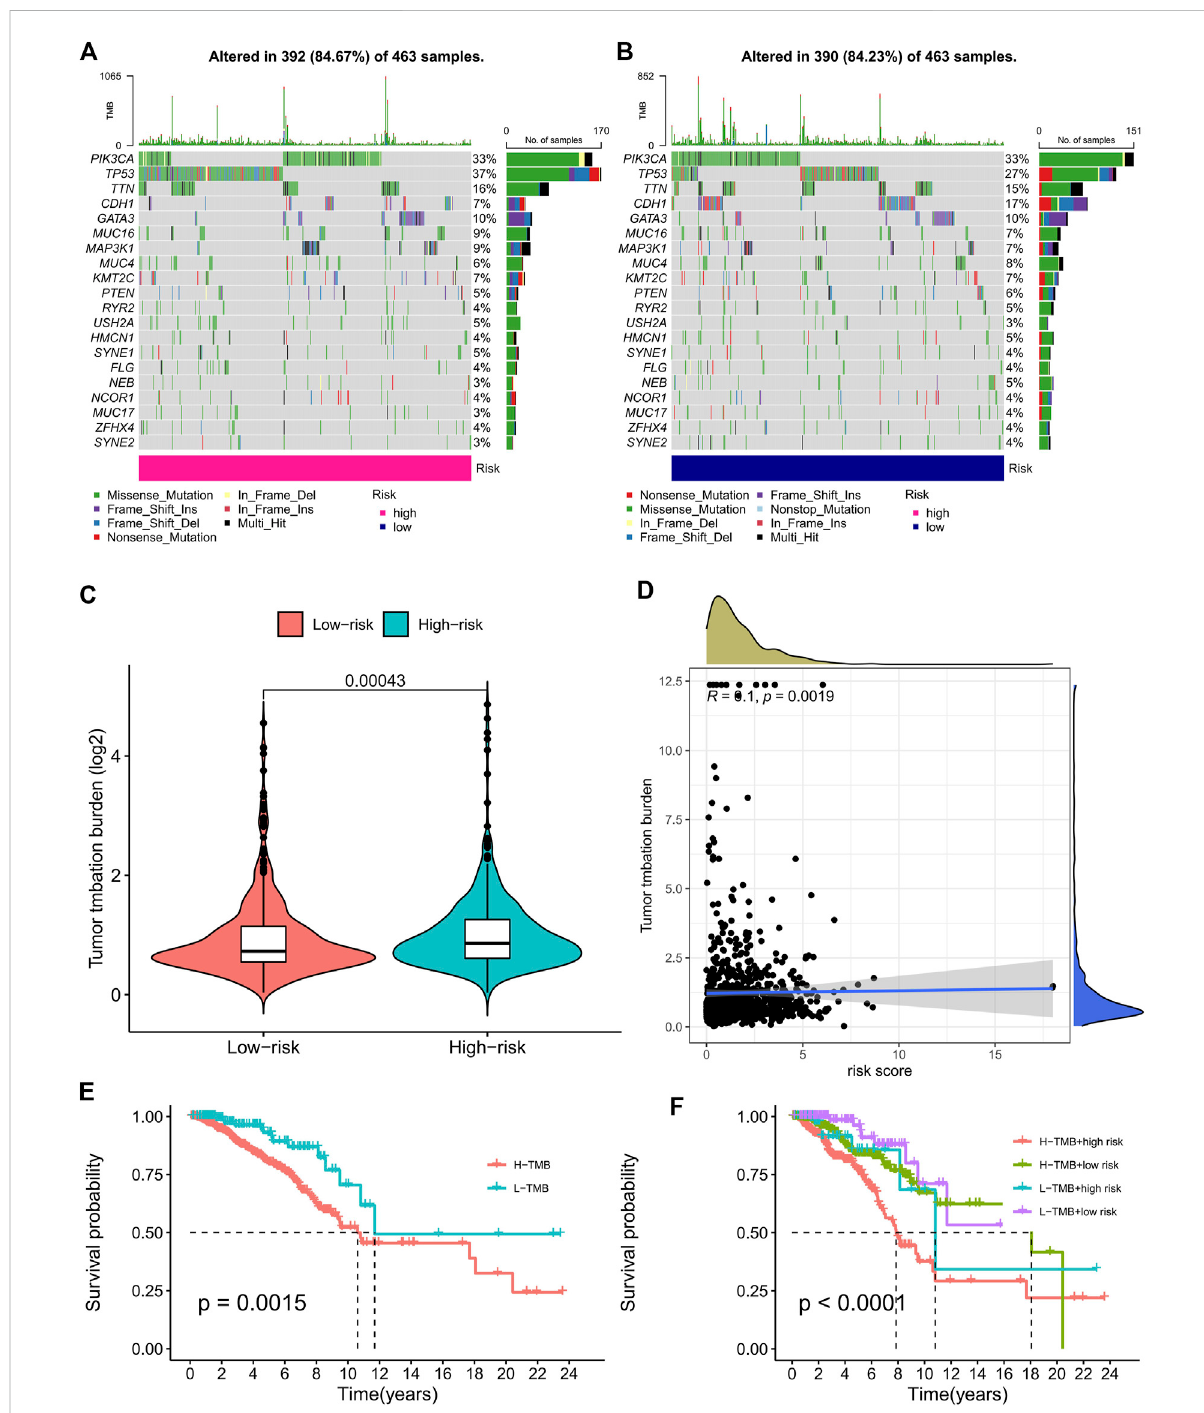
FIGURE 5 TMB analysis of the prognostic signature. (A,B) The waterfall plots of the tumor mutation rate in the high-risk group (A) and low-risk group (B) based on the prognostic signature. (C) The bean plot for the differences in TMB between high- and low-risk groups. (D) The correlation curve between TMB and the risk score. (E) Kaplan – Meier survival curves of BC patients between the H-TMB and L-TMB groups. (F) Kaplan – Meier survival curves of BC patients across H-TMB + high risk, H-TMB + low risk, L-TMB + high risk, and L-TMB + low risk. TMB, tumor mutational burden; H, high; L,